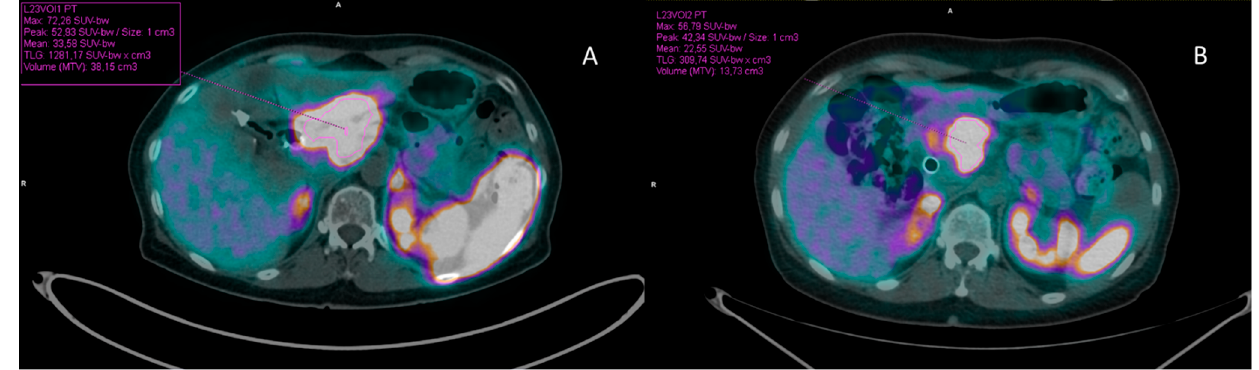
Figure 1. Illustrates the procedure to semiautomatically calculate the metabolic parameters, including those objects of the study, such as SRETV and TLSRE in baseline ( A ) and post ‐ PRRT [ 68 Ga]Ga ‐ DOTATOC PET/CT in a patient affected by a pancreatic NET ( B